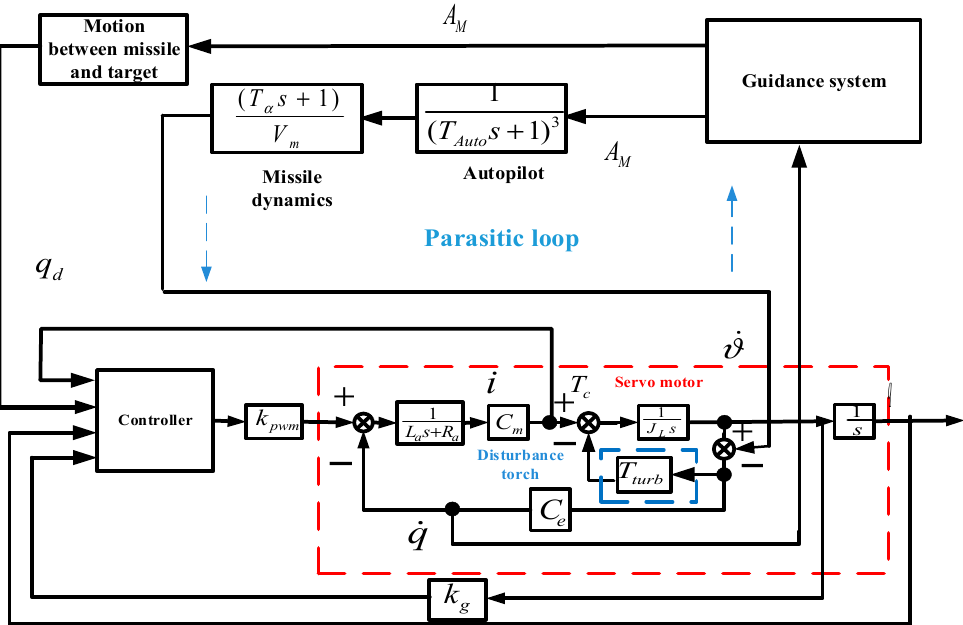
Figure 5. Complete model of missile control system (SGCS).